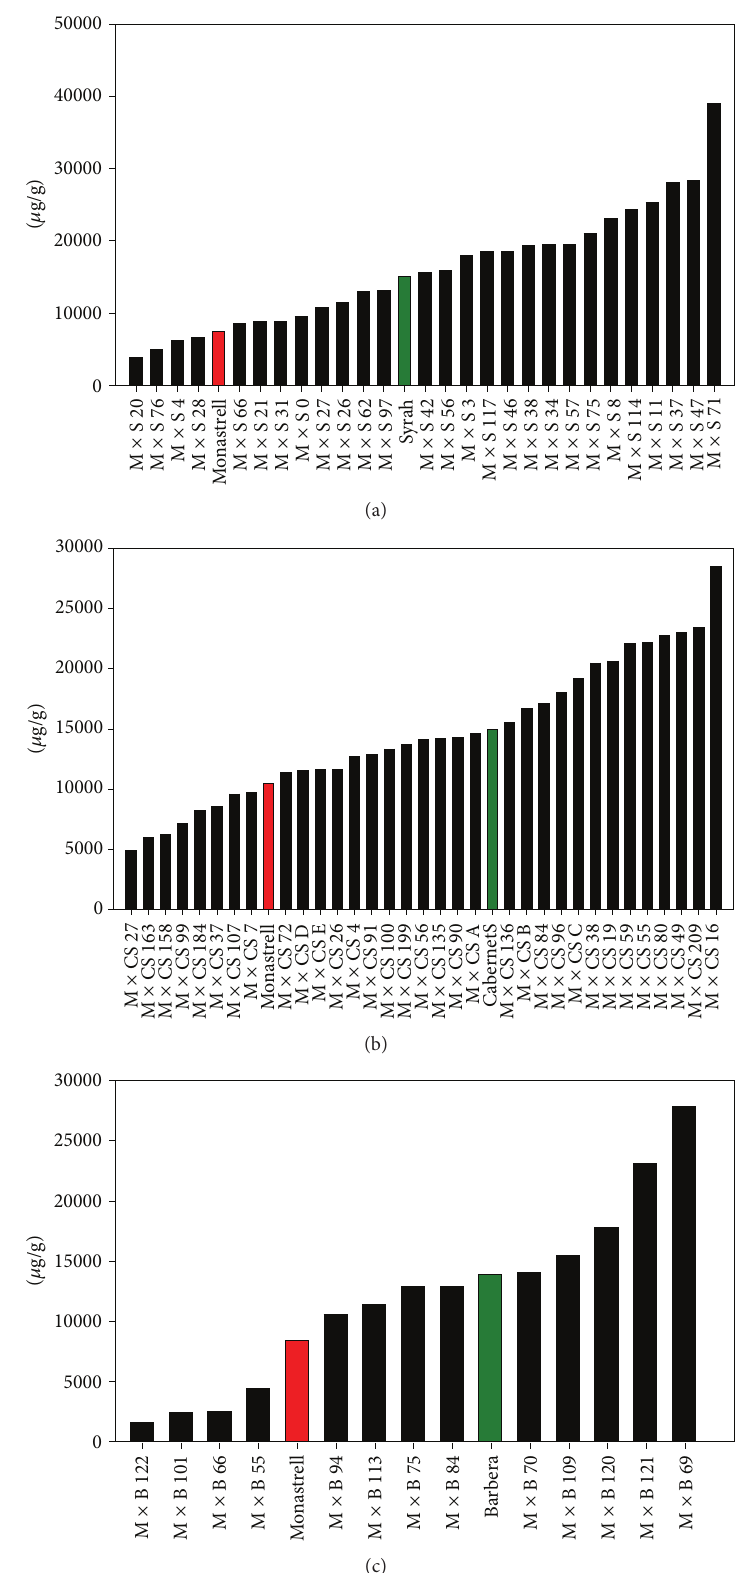
Figure 2: Concentration of anthocyanins in Monastrell × Syrah (a), Monastrell × Cabernet Sauvignon (b), and Monastrell × Barbera (c) hybrid grapes (each bar represents the mean value of three